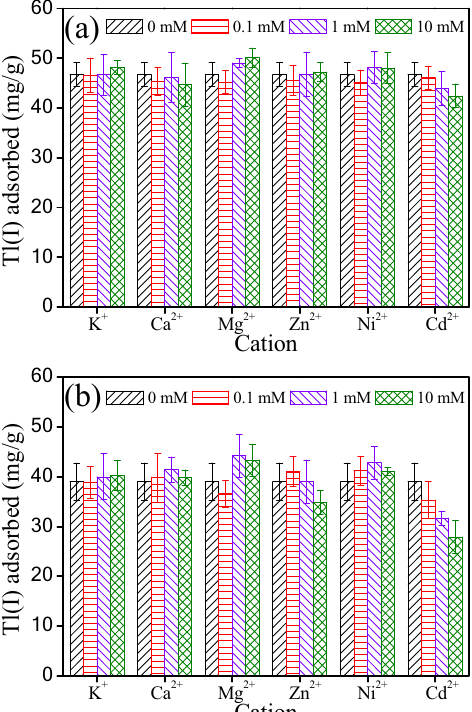
Figure 7. Influence of coexisting cations on Tl(I) adsorption by the TiO 2 I ( a ) and TiO 2 II ( b ). Experiment